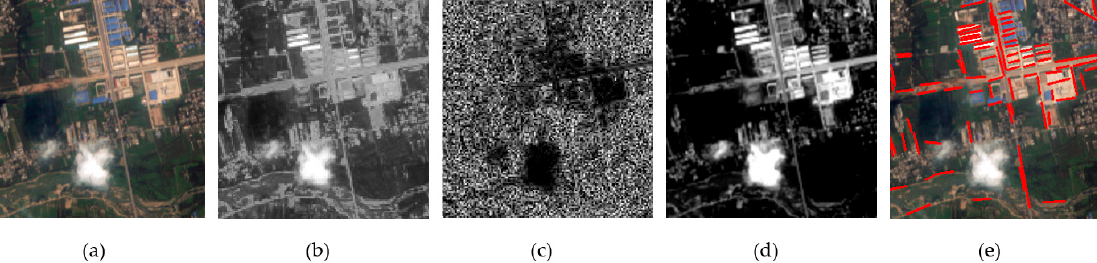
Figure 5. Complicated features of a graphic example. ( a ) Original image; ( b ) SF image; ( c ) TF image; ( d ) FF image; ( e ) LSD. ( d ) FF image; ( e )